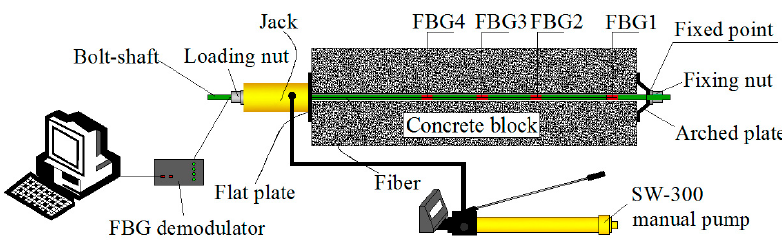
Figure 12. Schematic diagram of the experiment. Sensors 2019 , 19 , x FOR PEER REVIEW